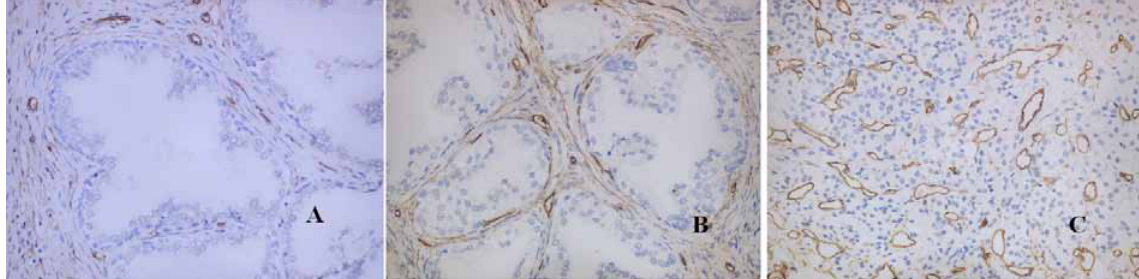
Figure 3. In CEACAM5 positive areas, MVD shows significant difference in BPH(A), PIN(B) and PCa(C). 400×